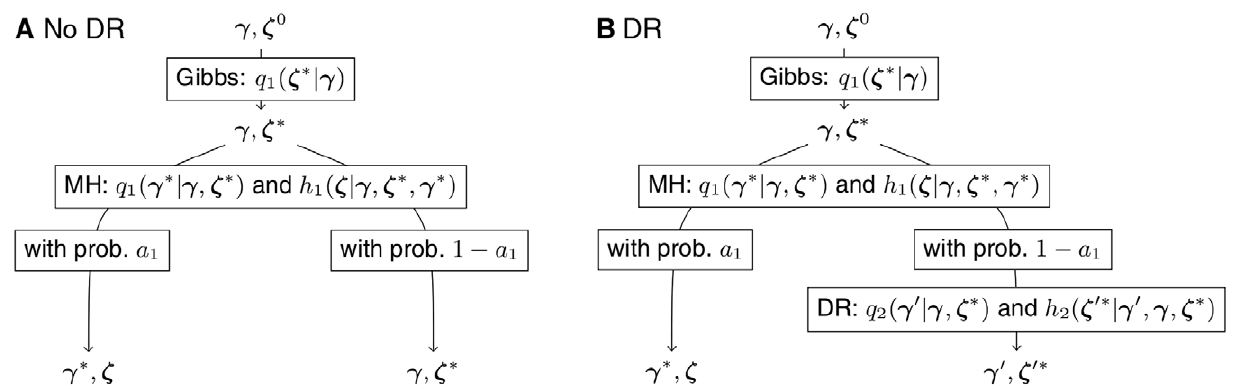
Figure 2. Flow diagram of the proposal. A. View of the full move as a Gibbs step followed by a Metropolis-Hastings (MH) step. B. Delayed rejection (DR): a second proposal may be done when the first proposal is rejected. Since the DR proposal is constructed here such that it is always accepted, there is no further branching after the second proposal. a 1 is the acceptance probability of the MH step. z 0 refers to an old value of the auxiliary variable, which is